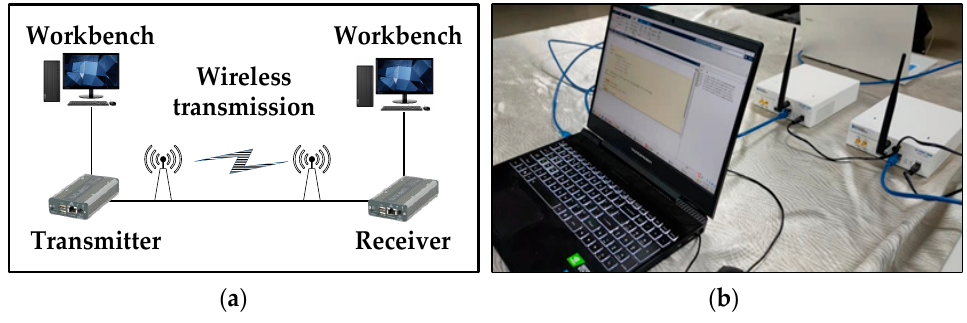
Figure 1. RF acquisition system. ( a ) Hardware connection; ( b ) USRP 2920. Table 1. Delay and power distribution for multipath channels. Path